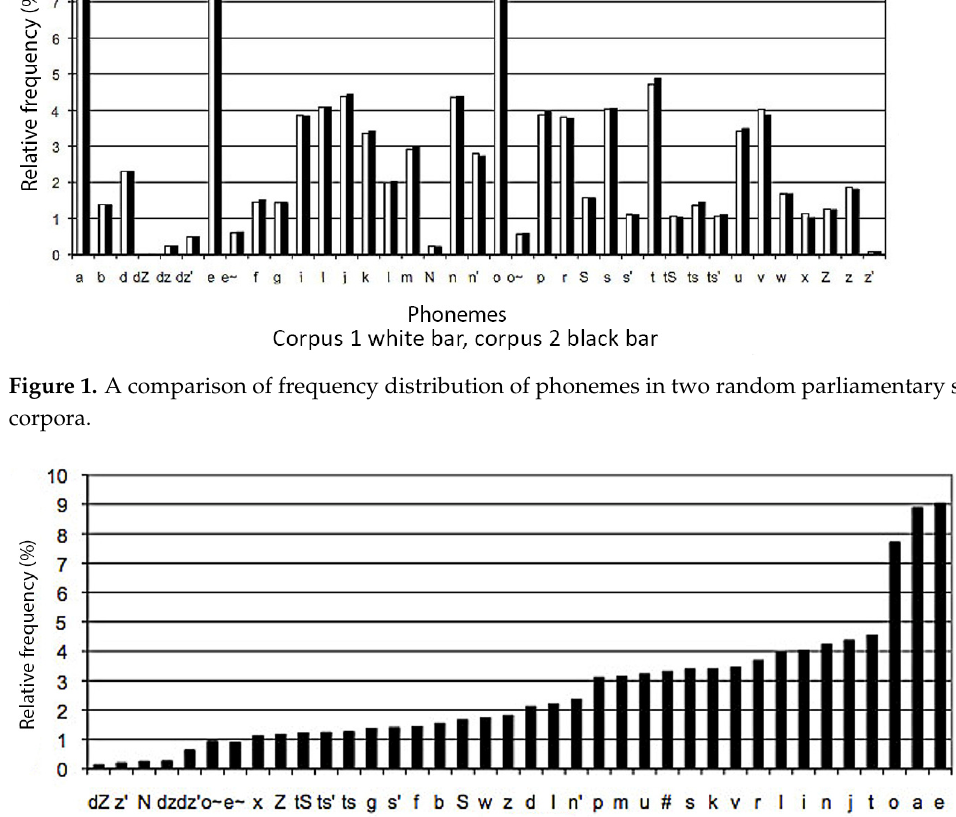
Figure 1. A comparison of frequency distribution of phonemes in two random parliamentary sub- corpora.